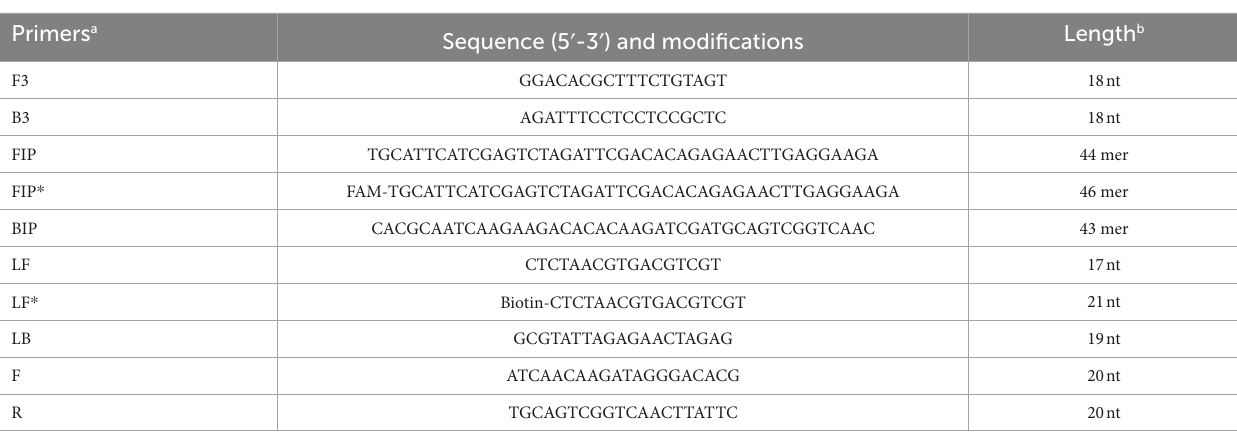
TABLE 1 Sequences and modifications of the MPX-LAMP-LFB